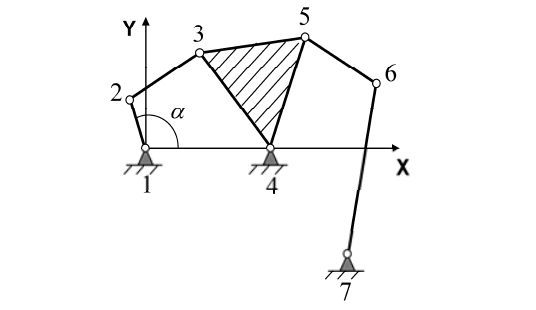
Fig. 8 Mechanism of six bars of Watt